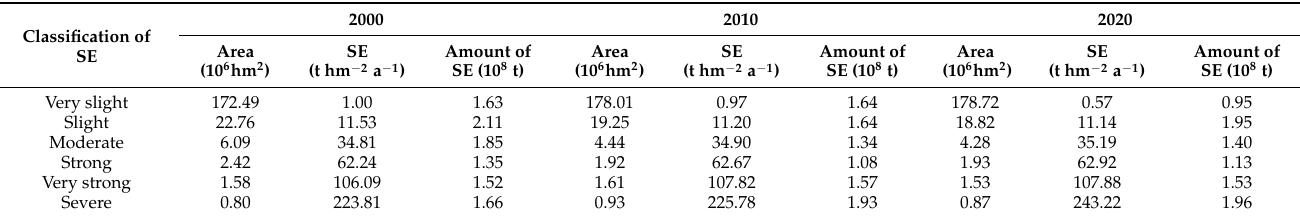
Table 3. Characteristics of different soil erosion intensities from 2000 to